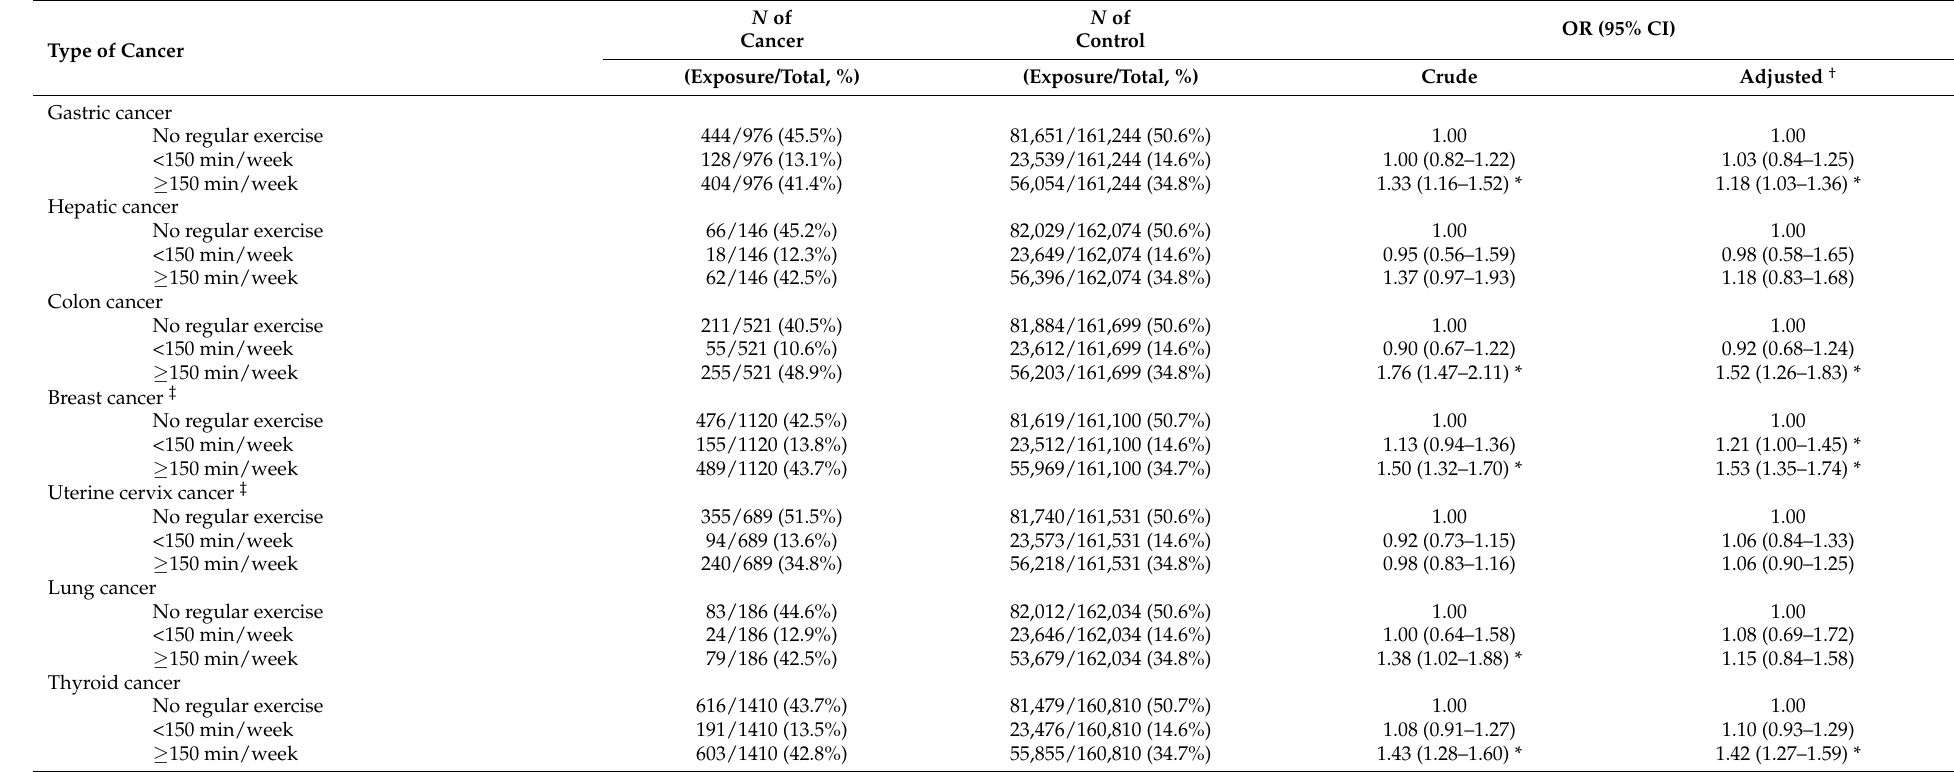
Table 3. Crude and adjusted odd ratios (95% confidence interval) of physical exercise for various cancer